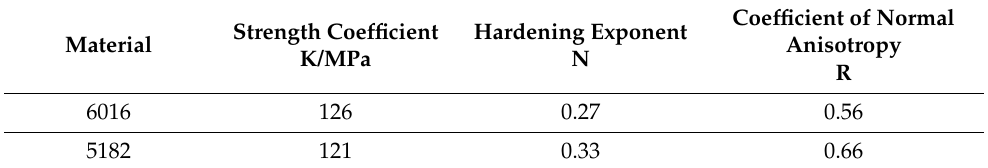
Figure 4. The stress-strain response of AA6016 and AA5182.